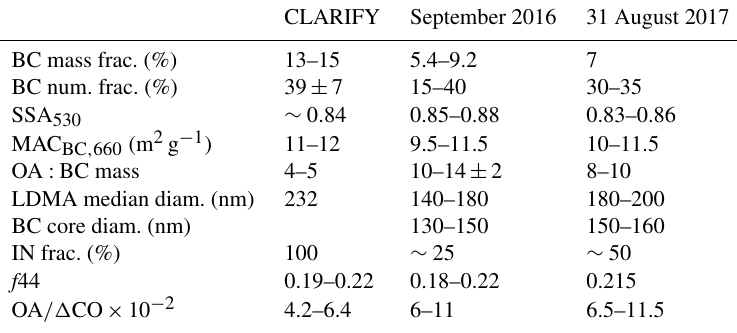
Table 3. Comparison of level-leg mean values to CLARIFY.